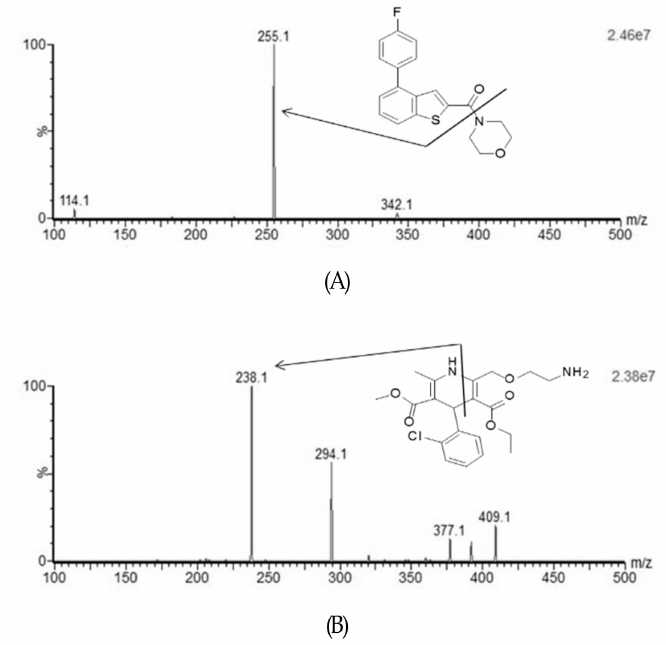
Figure 1. Positive ion electrospray mass scan spectra of CK41016 ( A ) and the internal standard (IS) ( B